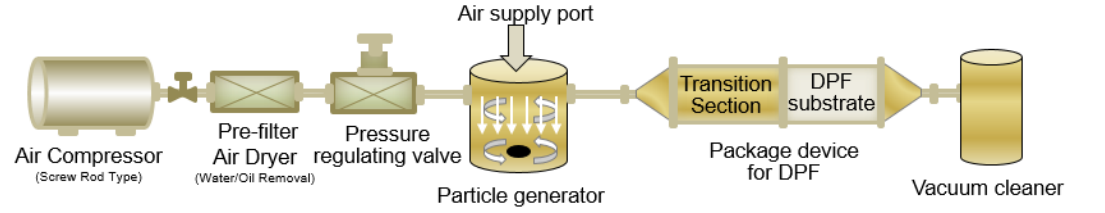
Figure 1. Schematic of the DPF loading system [18].